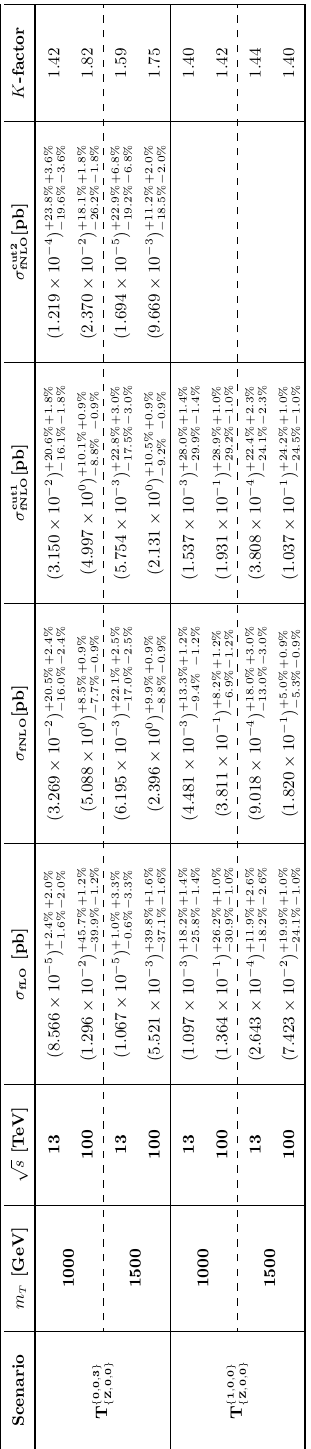
Table 2 . fLO and fNLO cross sections in 6FS. For (cid:27) cut1 M > 2 m t . For (cid:27) cut2 t (cid:22) t column, is de(cid:12)ned by the fractions: (cid:27) cut1